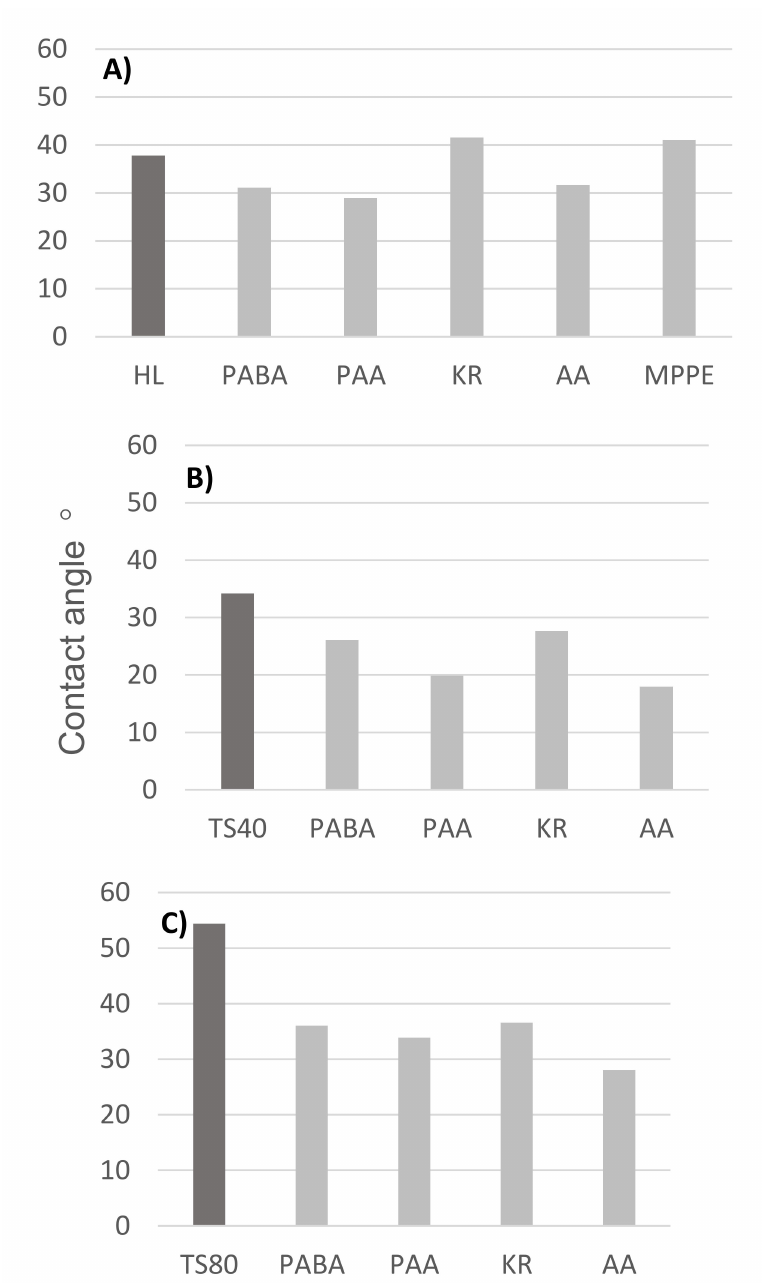
Figure 7. The values of the contact angle of the membranes ( A ) HL, ( B ) TS40 and ( C ) TS80 after the nanofiltration process for the selected compounds; dark gray bar—new, clean membrane; light gray bars—membranes after filtration process of PABA, PAA, KR and